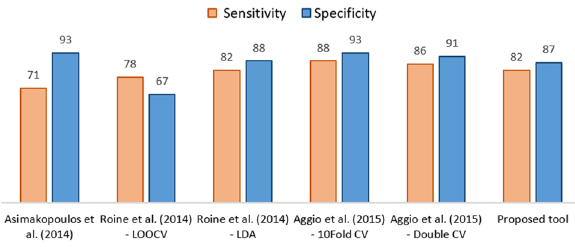
Figure 4. Comparison of the classification performance of the proposed diagnostic tool with ones achieved by different literary